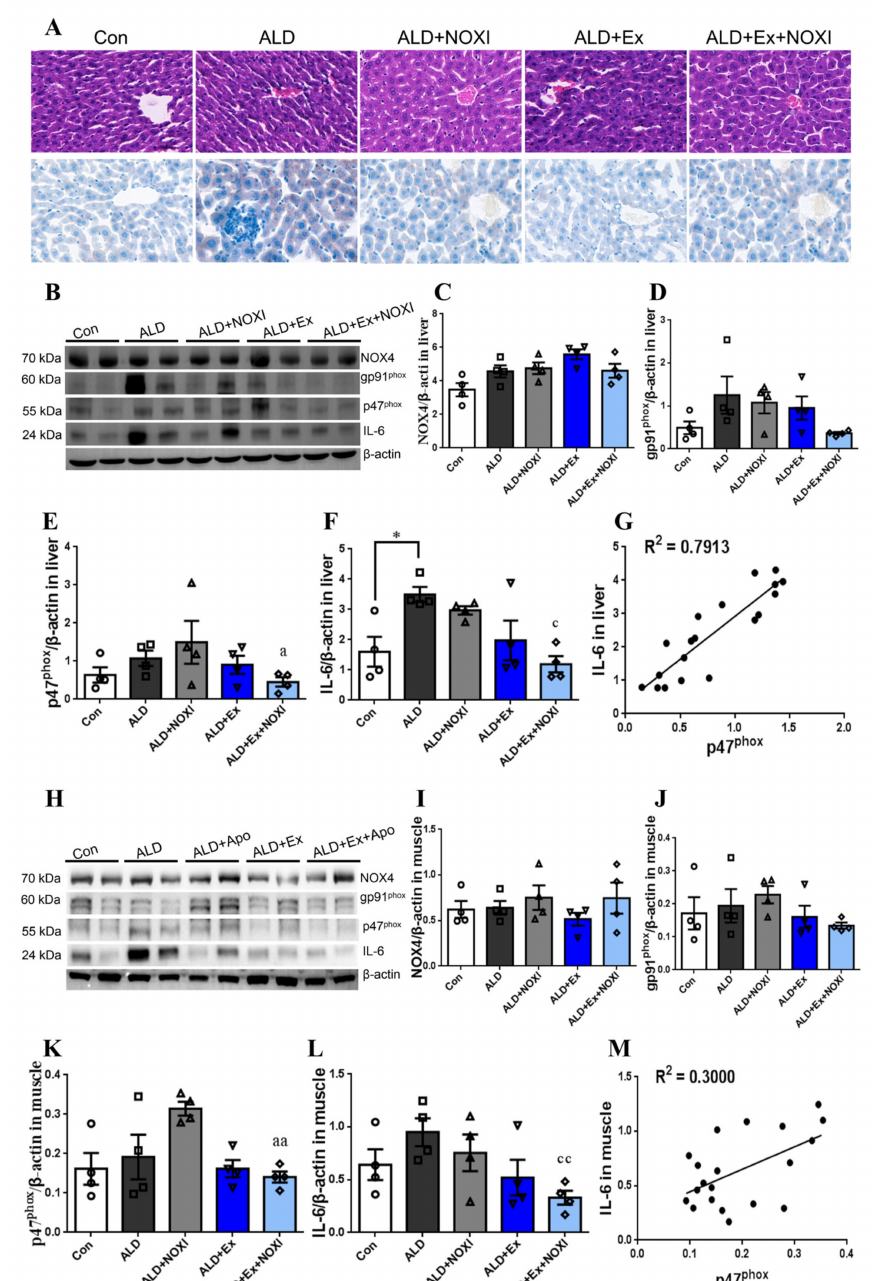
Figure 3. Exercise significantly improved fat accumulation and inflammatory injury in liver tissue. Exercise inhibited the expression of p47 phox and IL-6 proteins, and they were highly correlated in liver tissue. ( A ) The upper row is the result of HE staining, and the lower row is the result of Oil Red O staining. ( B – F ) NOX4, gp91 phox , p47 phox , and IL-6 protein expression levels in liver tissue by WB. ( G ) Correlation between IL-6 and p47 phox protein expression in liver tissue. ( H – L ) NOX4, gp91 phox , p47 phox , and IL-6 protein expression levels in skeletal muscle tissue by WB. ( M ) Correlation between IL-6 and p47 phox protein expression in skeletal muscle tissue. The molding effect is represented by *, * p < 0.05. The exercise effect is denoted by a, a p < 0.05, aa p < 0.01. The effect of combined exercise and drug intervention was indicated by c, c p < 0.05 and cc p <